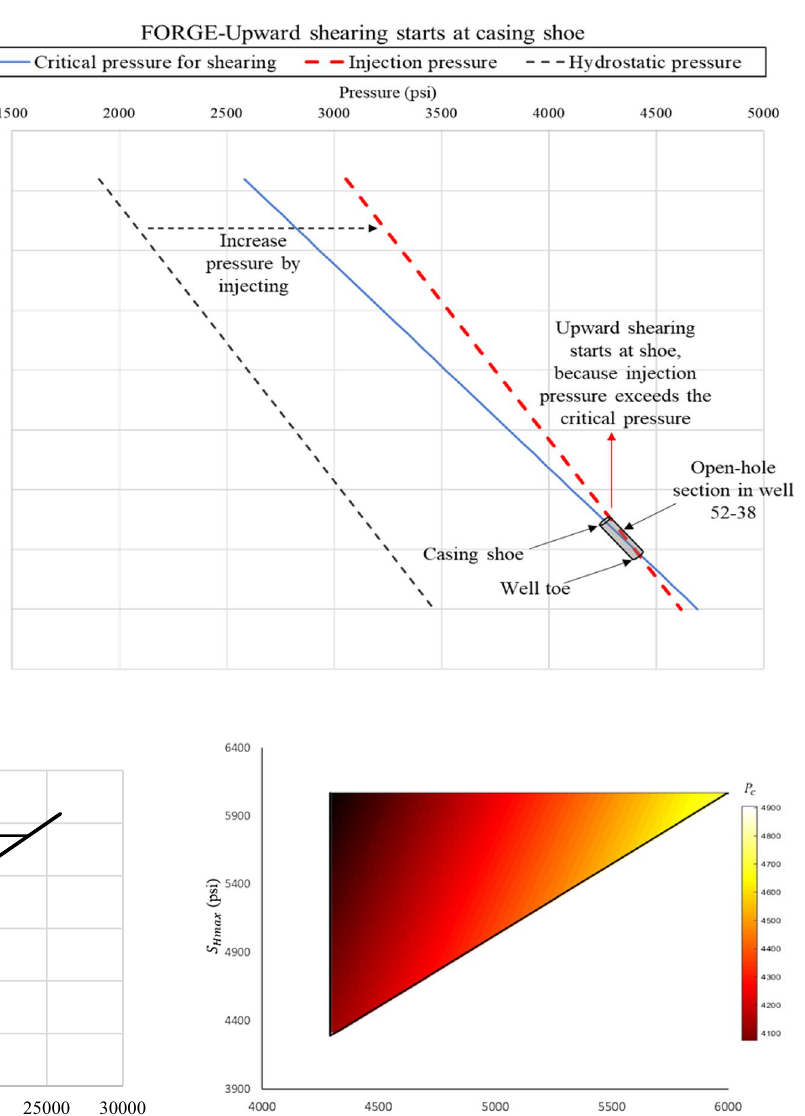
Fig. 2 Calculated critical pres-